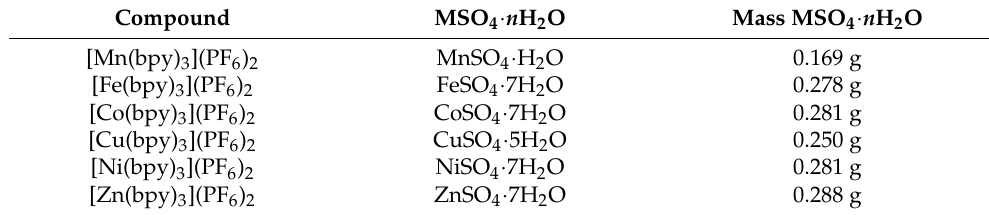
Table 1. Masses of metal sulfates used in the synthesis of pure [M(bpy) 3 ](PF 6 ) 2 compounds.